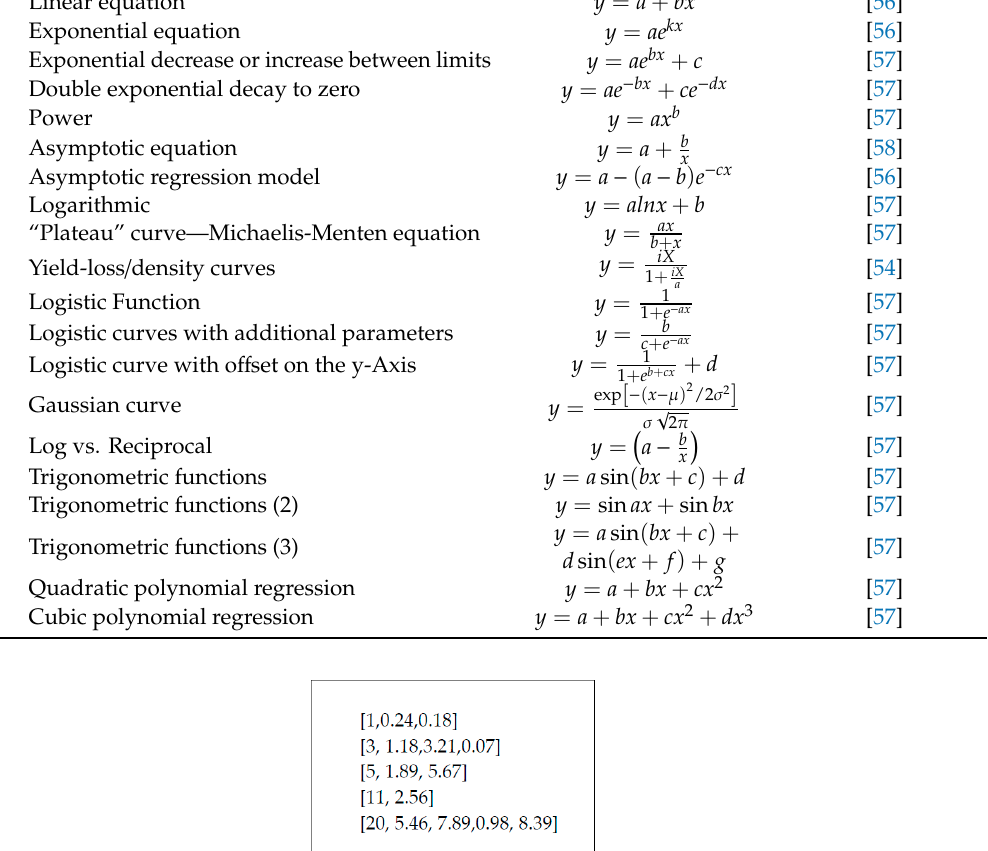
Figure 2. Swarm of five particles, using the proposed codification. The first component denotes the model number, as in Table 2, and the remaining ones the parameters to optimize of the selected model.